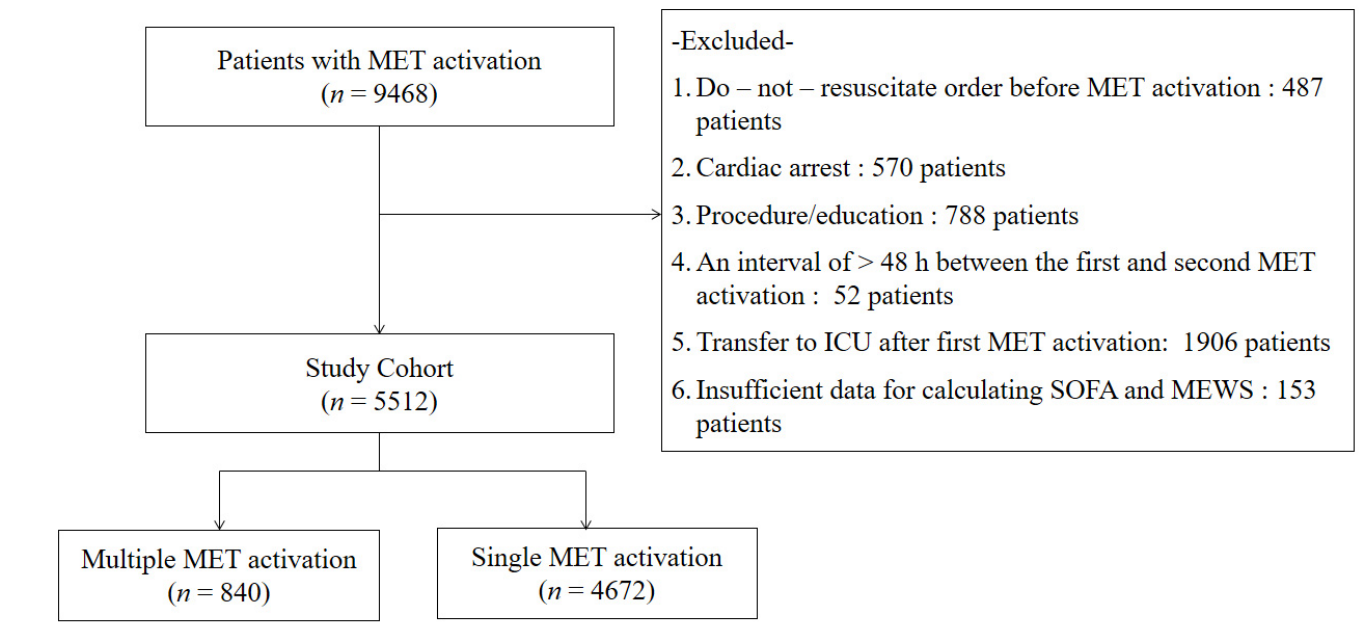
Figure 1. Flow diagram of patients. MET = medical emergency team; SOFA = Sequential Organ Failure Assessment; MEWS = Modified Early Warning Score.